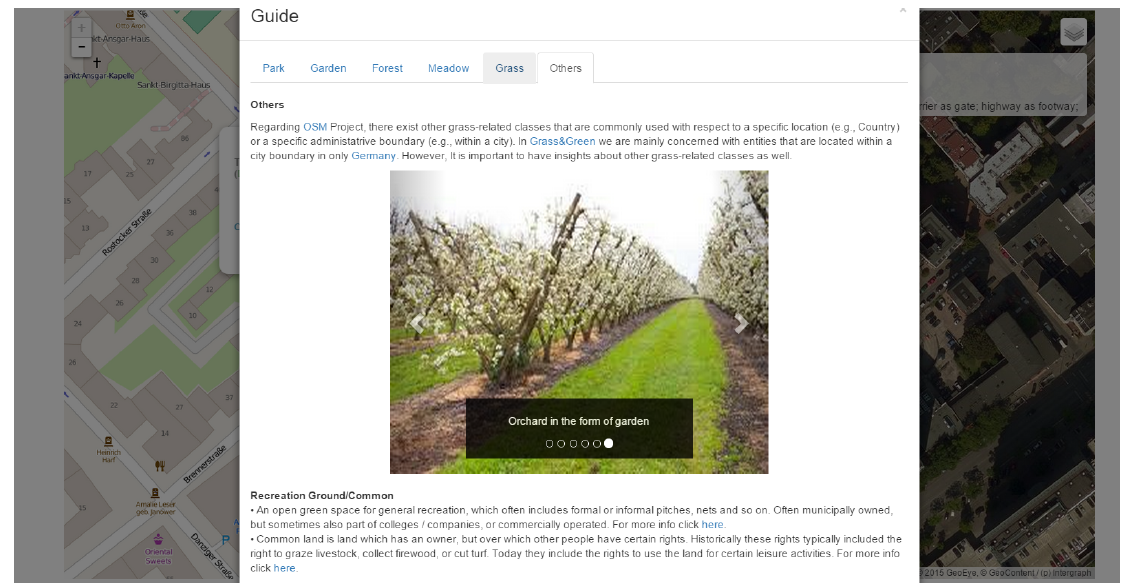
Figure 5. Textual and visual descriptions of target classes.